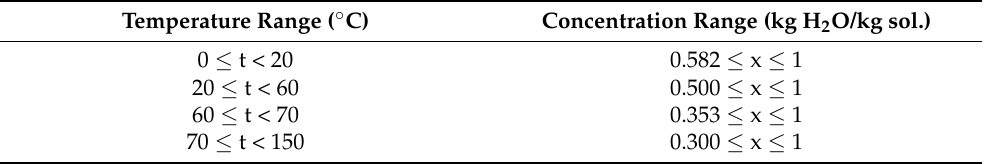
Table A34. Temperature range of the H 2 O-NaOH saturated pressure equation.